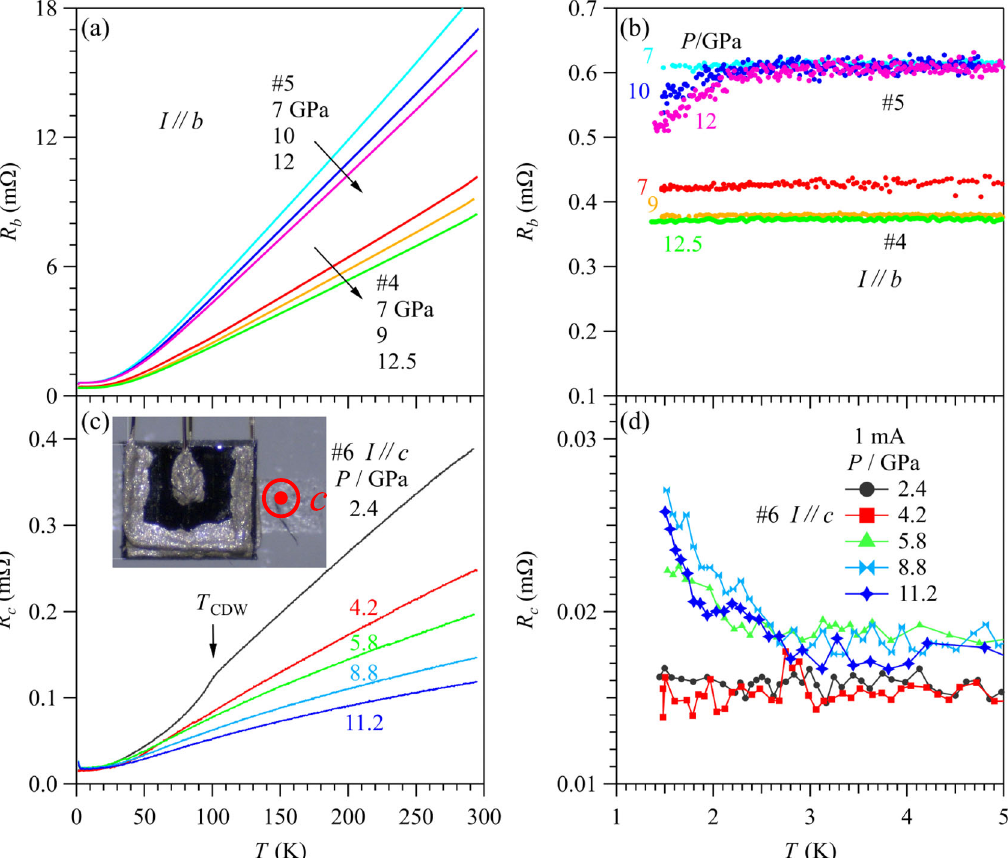
Fig. 5 The b - and c -axis resistance under high pressure. a The temperature dependence of b -axis resistance R b ( T ) under different pressures from 7 to 12.5 GPa for two samples (#4 and #5) and b their low-temperature data. c The temperature dependence of c -axis resistance R c ( T ) under different pressures from 2.5 to 11 GPa for sample #6 and d their low-temperature parts below 5 K. The inset of ( c ) shows the photo of the sample for the resistance measurement along c